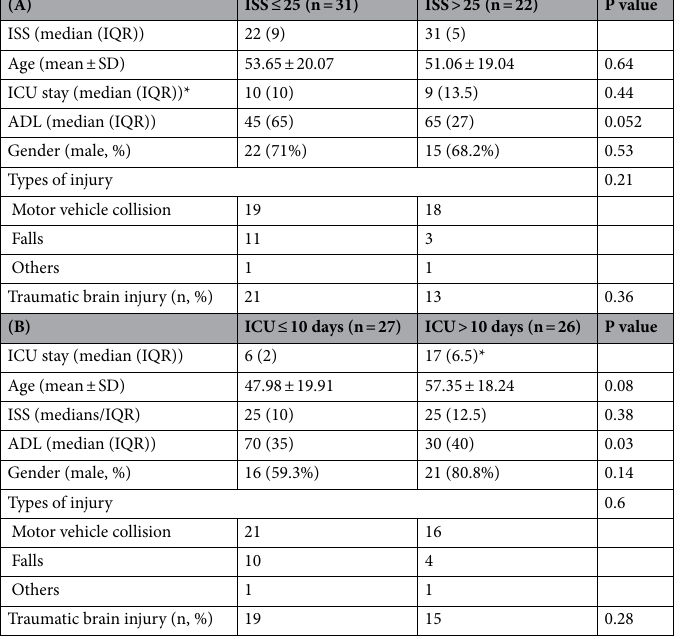
Table 1. Baseline characteristics of trauma patients grouped by ISS (A) and ICU stay (B). *Except the patients who died during